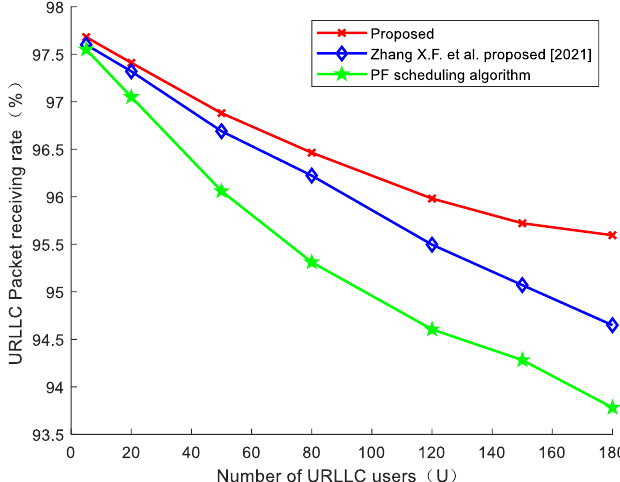
Figure 3. Packet reception rates under different URLLC allocation policies.